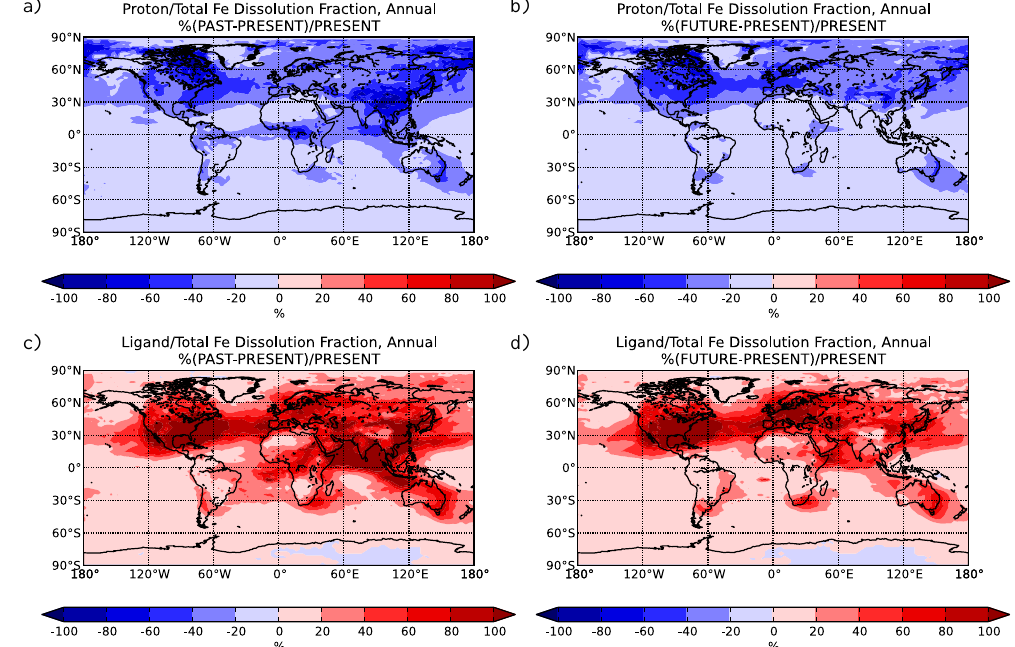
Figure 8. The percentage differences of PAST (a, c, e) and FUTURE (b, d, f) simulations from the PRESENT simulation for (a, b) proton- promoted/total mineral-Fe dissolution fraction and (c, d) ligand-promoted/total mineral-Fe dissolution fraction.